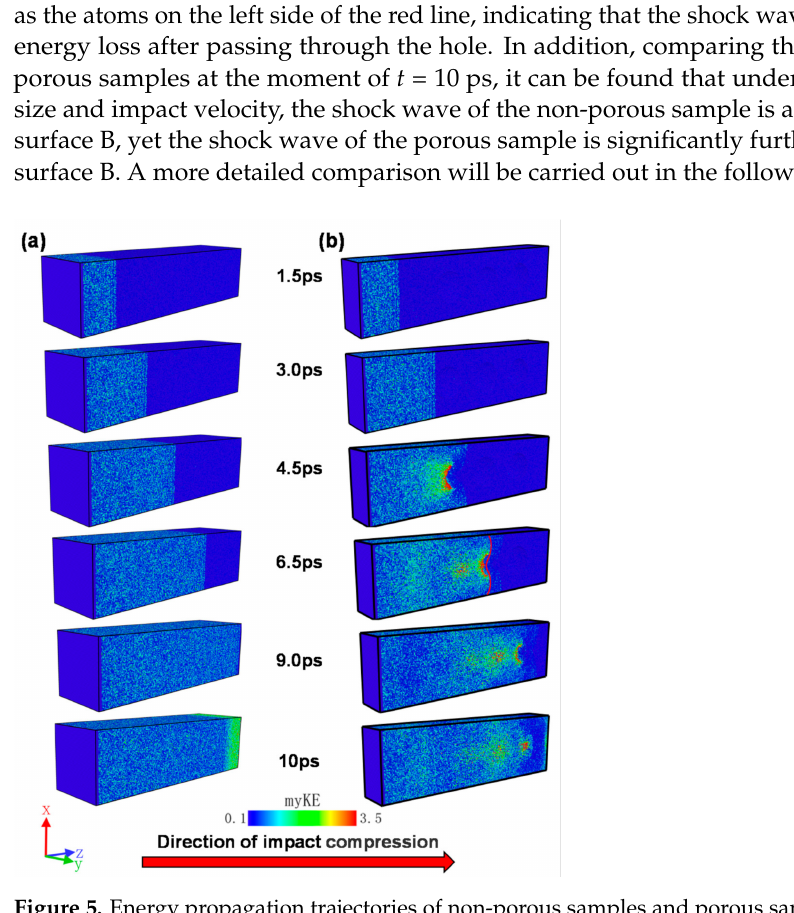
Figure 5. Energy propagation trajectories of non-porous samples and porous samples during impact compression: ( a ) non-porous samples; ( b ) porous